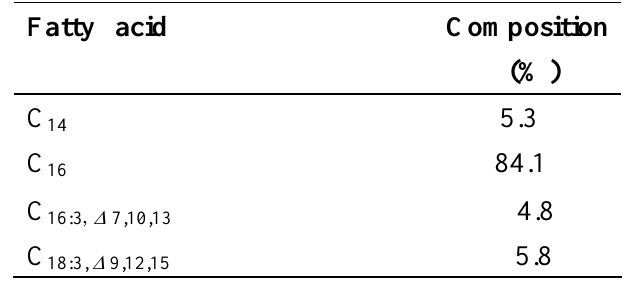
Table 2. Fatty acid composition of 2-acyloxyethanephosphonate